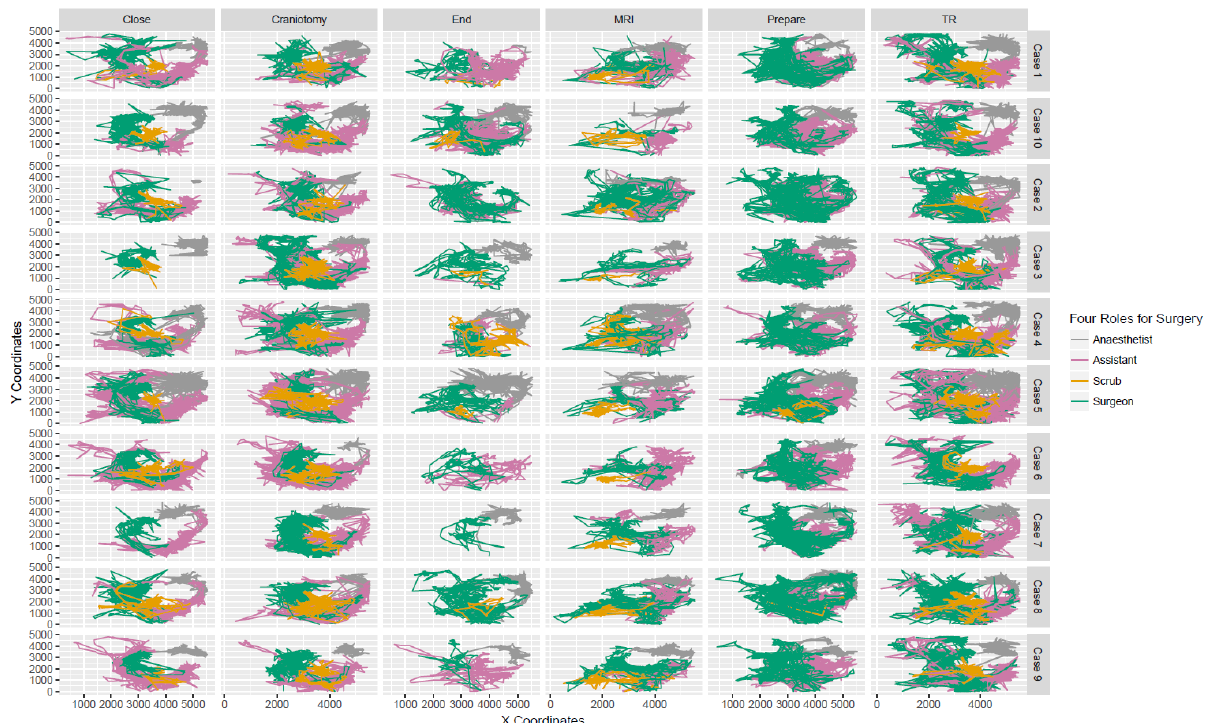
Figure 4. Movement Trajectories per surgical role per surgical phase.